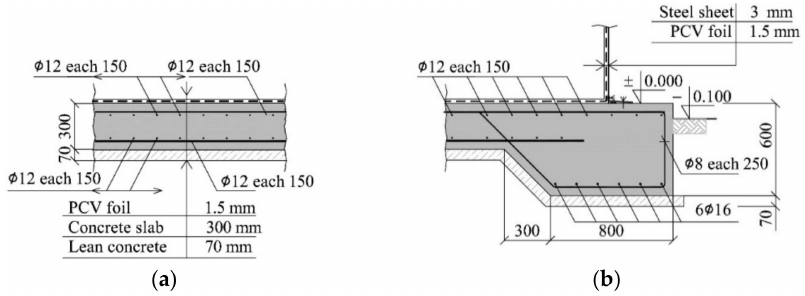
Figure 2. Reinforced concrete foundation slab of the tank: ( a ) detail “A” from Figure 1; ( b ) detail “B” from Figure